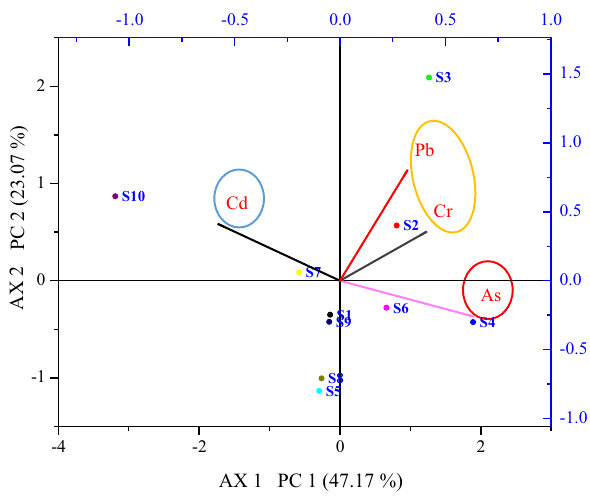
*Correlation is significant at the 0.05 level (2-tailed) **Correlation is significant at the 0.01 level